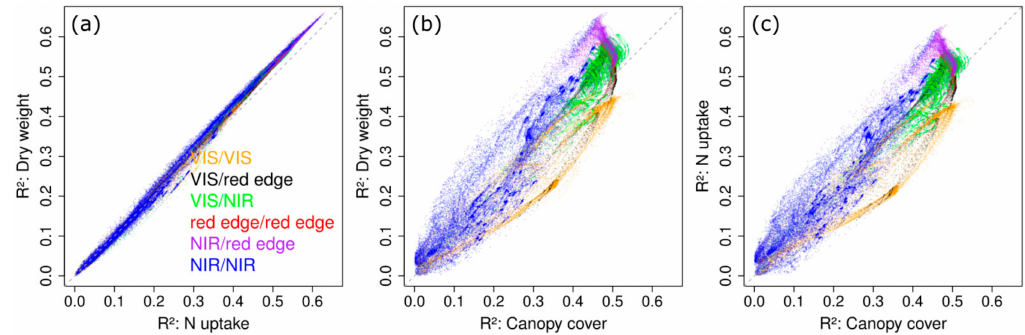
Figure 6. DW~Nup ( a ) DW~CC ( b ) and Nup~CC ( c ). Mean R 2 values across dates for DW, Nup and CC plotted against each other, colored by wavelength groups.